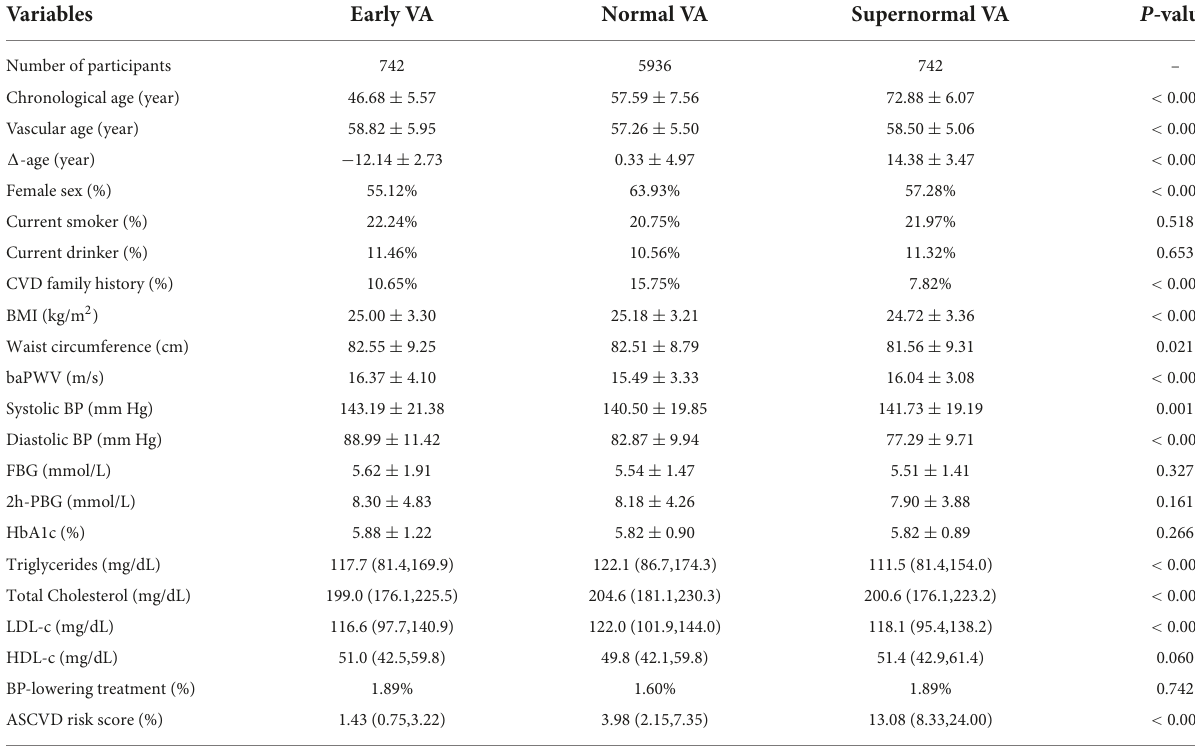
TABLE 1 Baseline clinical characteristics of three vascular aging categories